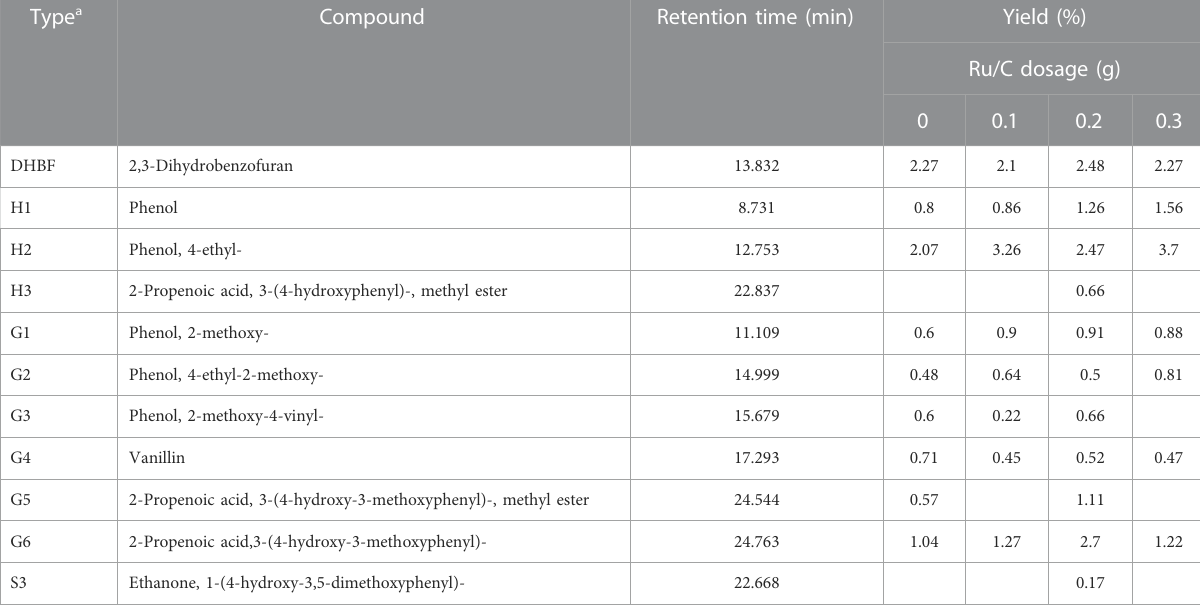
TABLE 3 Effect of Ru/C dosage on the distribution of lignin-derived aromatic monomers. Type a